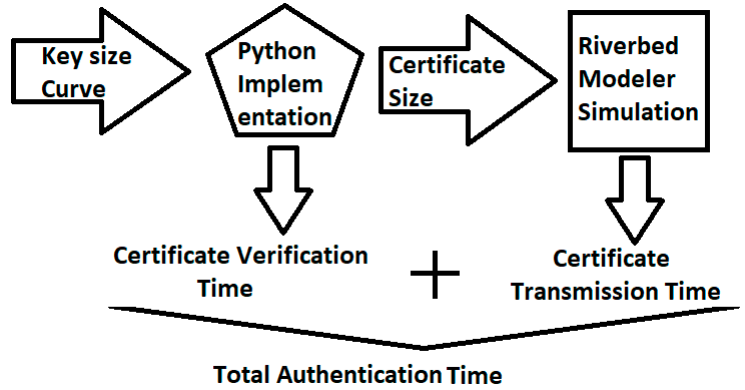
Figure 9. Timing performance with OpenSSL implementation and Riverbed